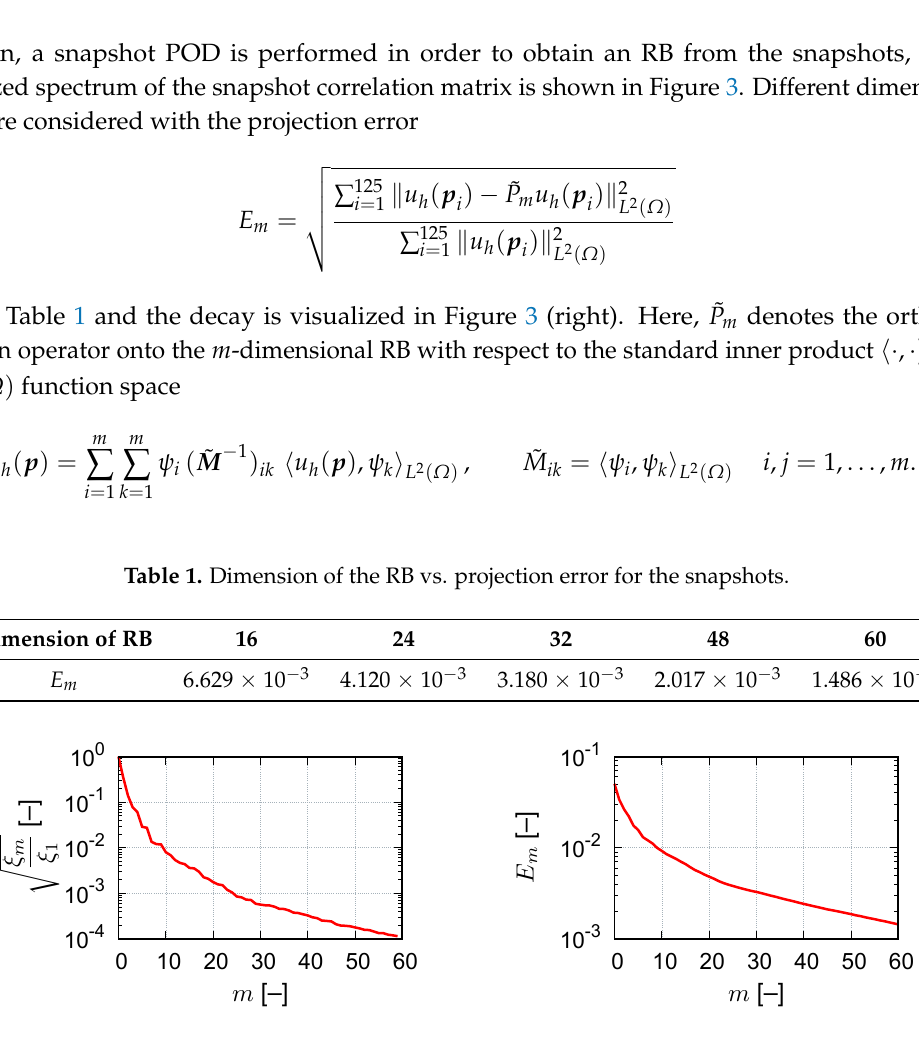
Figure 3. Decay of the spectrum of C (normalized to largest eigenvalue ξ 1 ) and the relative projection error E m of the snapshot data defined by